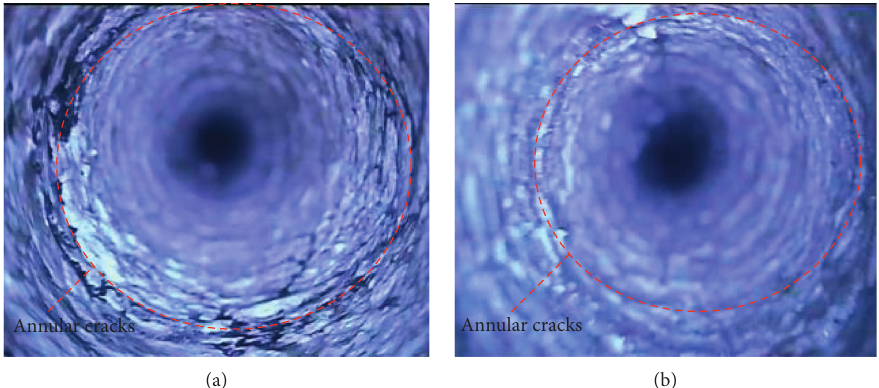
Figure 11: The peep results from the No. 2 monitor station: (a) 30cm; (b) 75